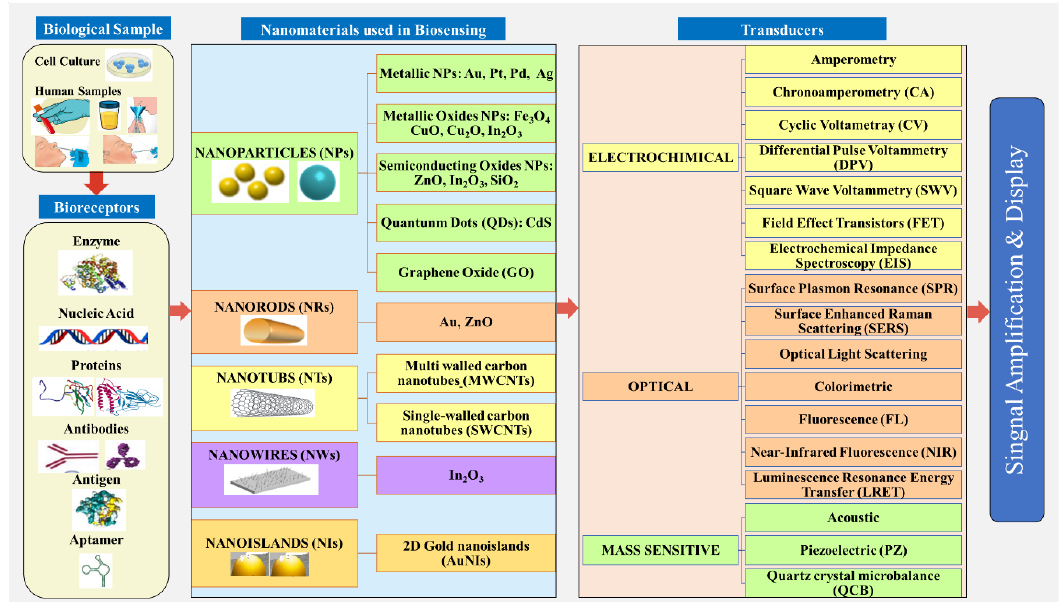
Figure 5. The schematic diagram of different analytes, bioreceptors for biorecognition elements, Figure5. transducers with integrated nanostructures as parts of a typical nanobiosensor design for respiratory viruses.